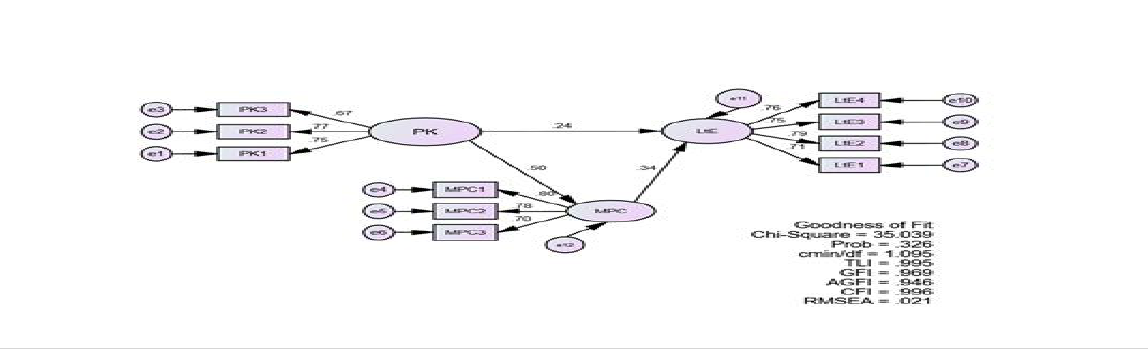
Figure 2. Redesign of the Research Constellation